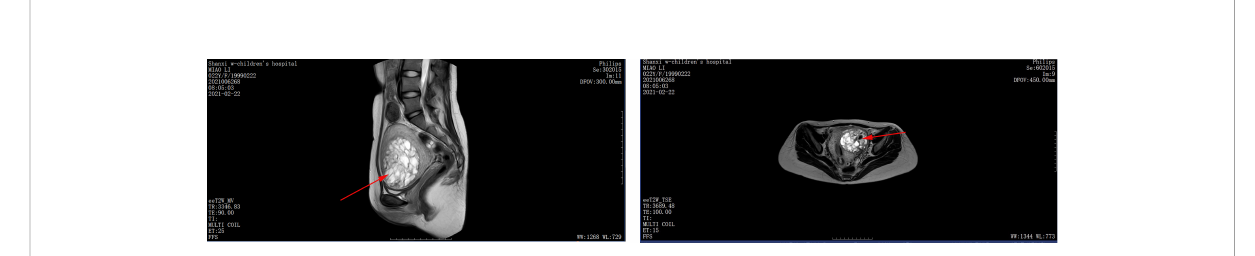
FIGURE 4 Pelvic MRI. Twenty-one days after the second molar evacuation, pelvic MRI scan showing a 7.1 × 6.1 × 8.2 cm mass invading the left anterior uterine wall, extending from the muscular layer to the serosal